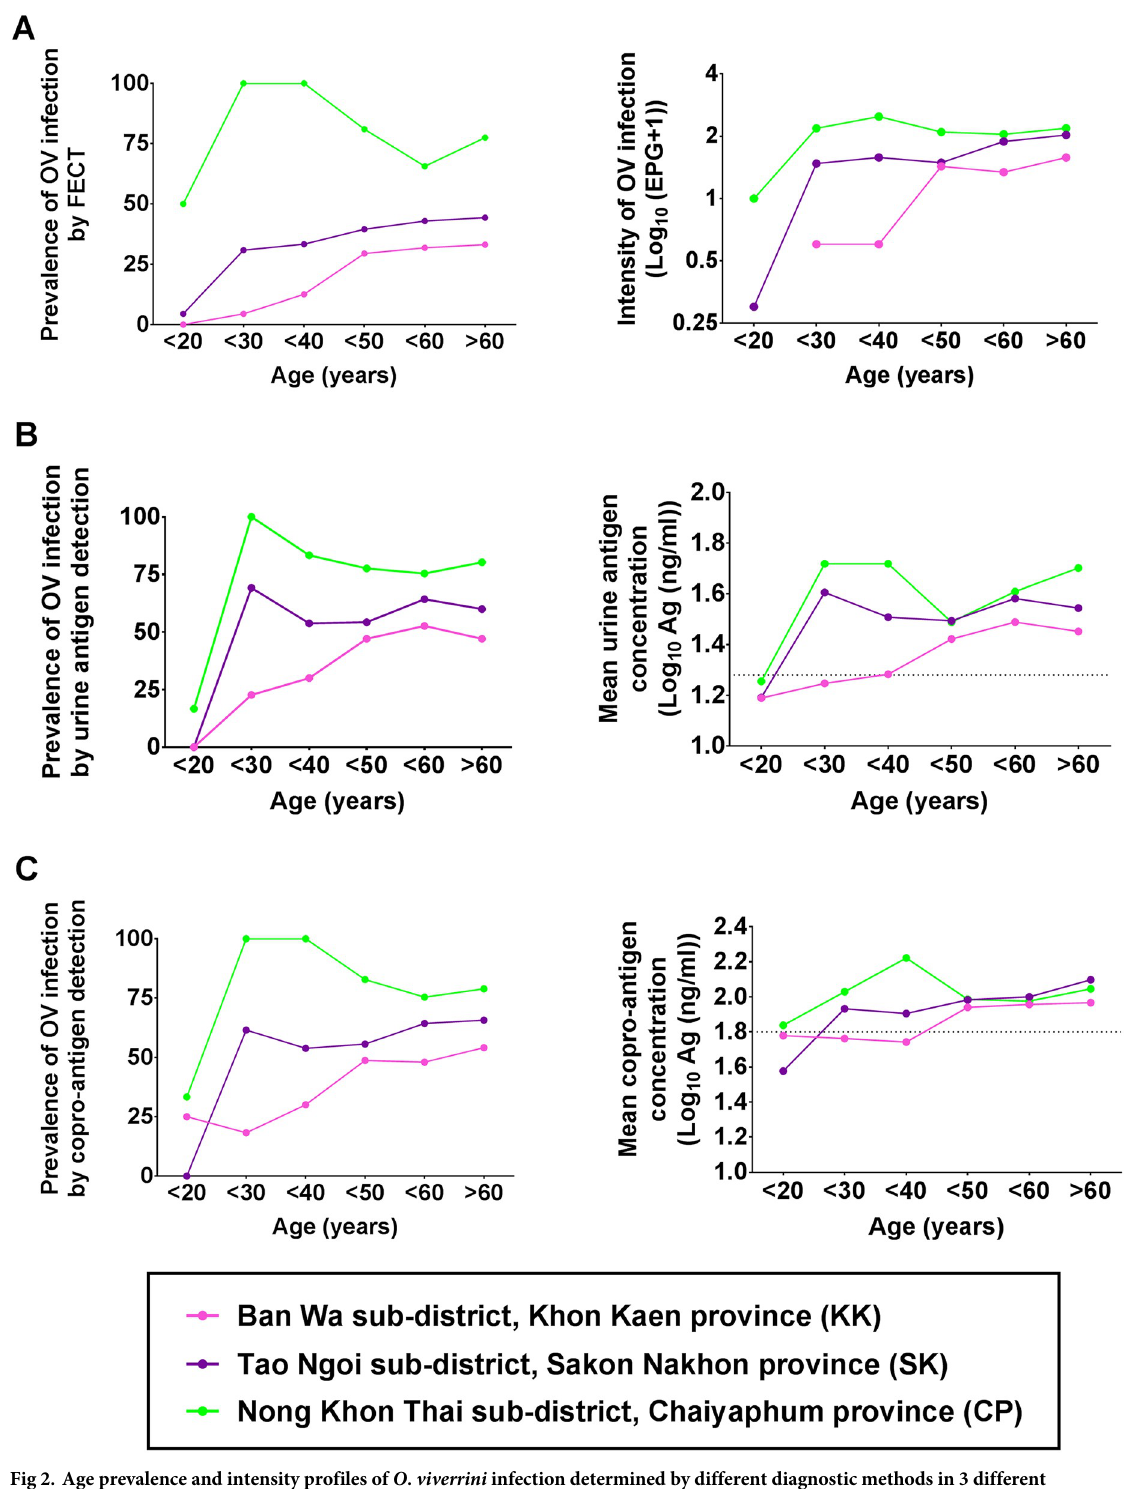
Fig 2. Age prevalence and intensity profiles of O . viverrini infection determined by different diagnostic methods in 3 different localities. (A) Determination of infection by FECT. (B) Urine antigen detection and (C) copro antigen detection measured by mAb-ELISA. The prevalence profiles of opisthorchiasis (left panel) and intensity of infection (right panel) are illustrated according to the age group and locality.